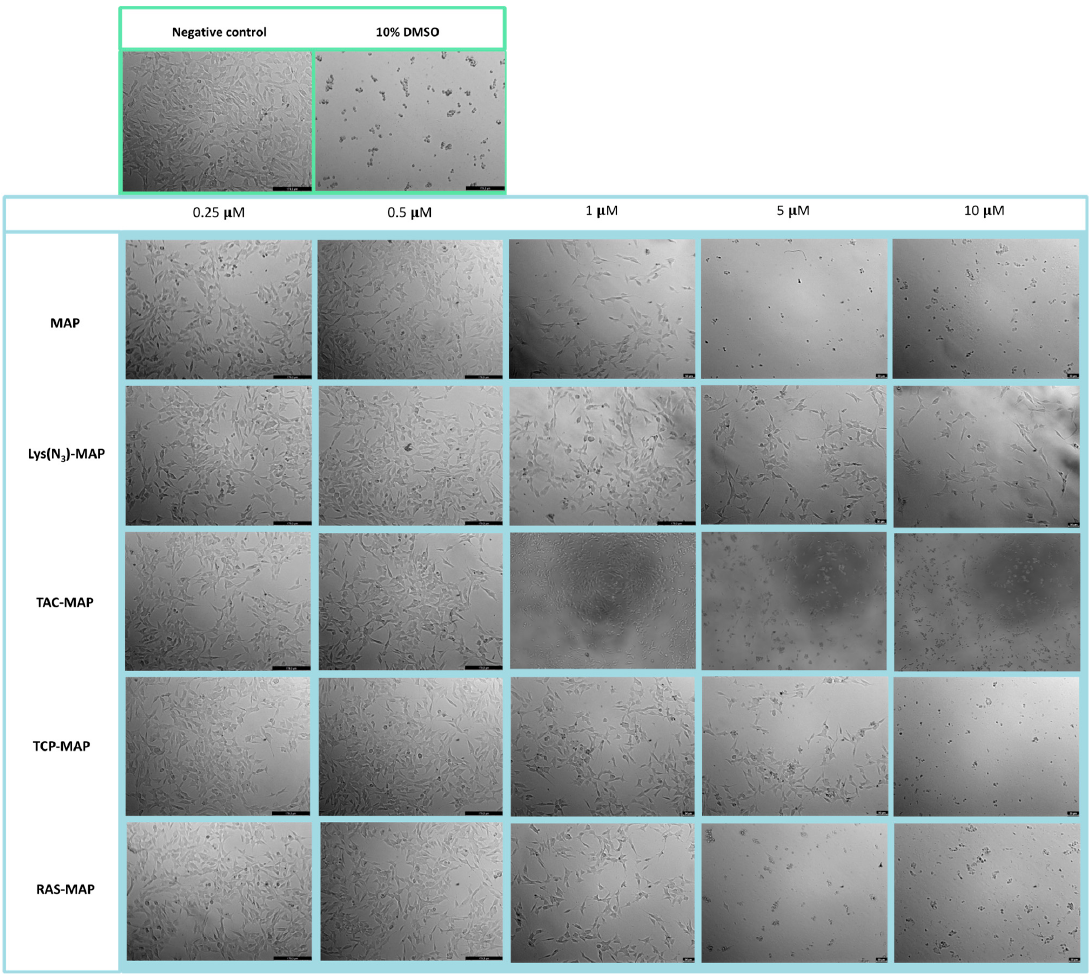
Figure 9. Microscope cellular visualization through Lionheart FX and Leica DFC350 FX of treatment with negative control (ultra-purified H 2 O), positive control (10% DMSO), free peptides, and conjugates on SH-SY5Y cell line at concentrations of 0.25, 0.5, 1, 5, and 10 µ M.